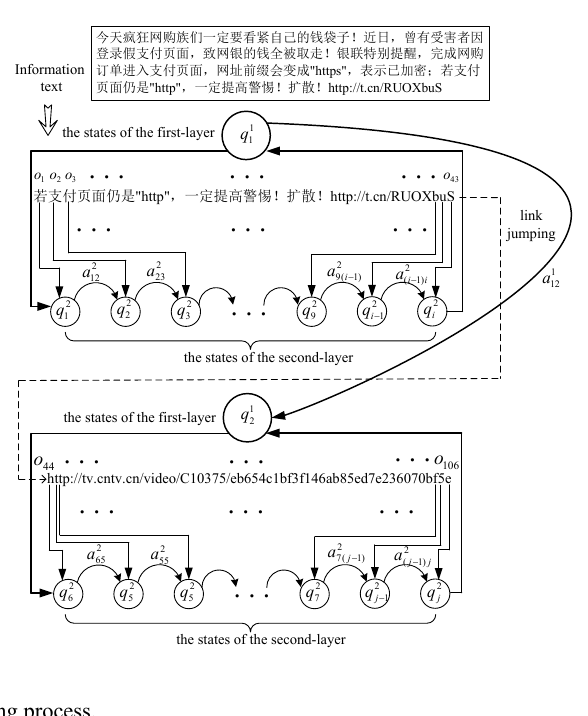
Fig. 1. Link jumping process.